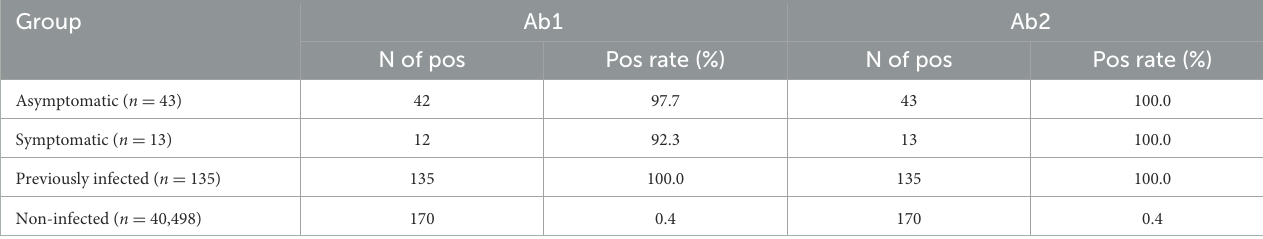
TABLE 5 Serology testing results of the population.